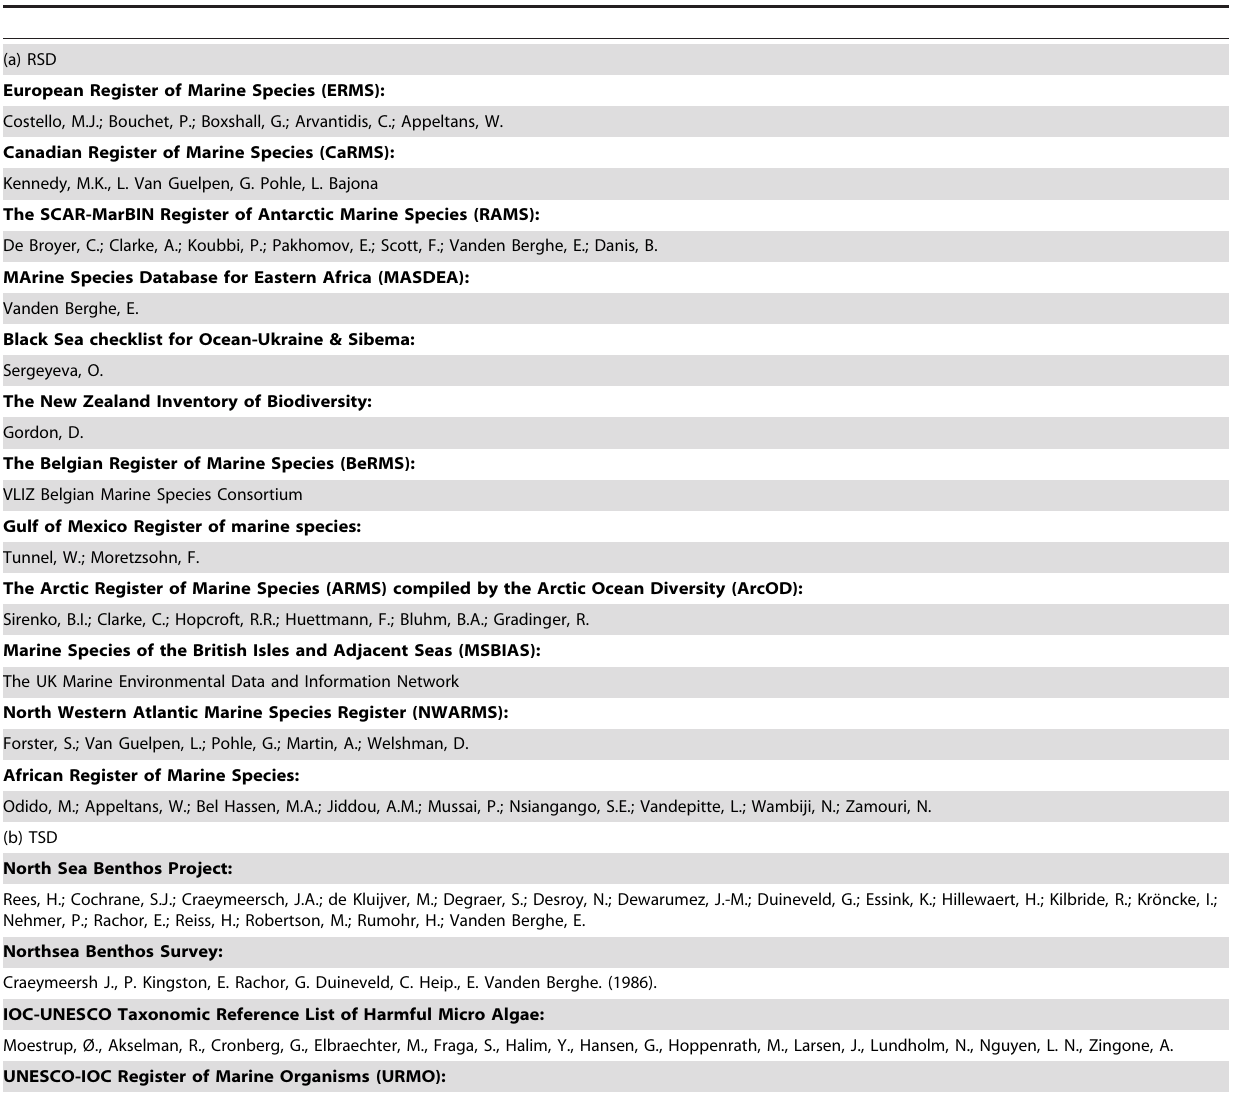
Table 3. The (a) Regional Species Databases (RSD) and (b) Thematic Species Databases (TSD), hosted within WoRMS, and their